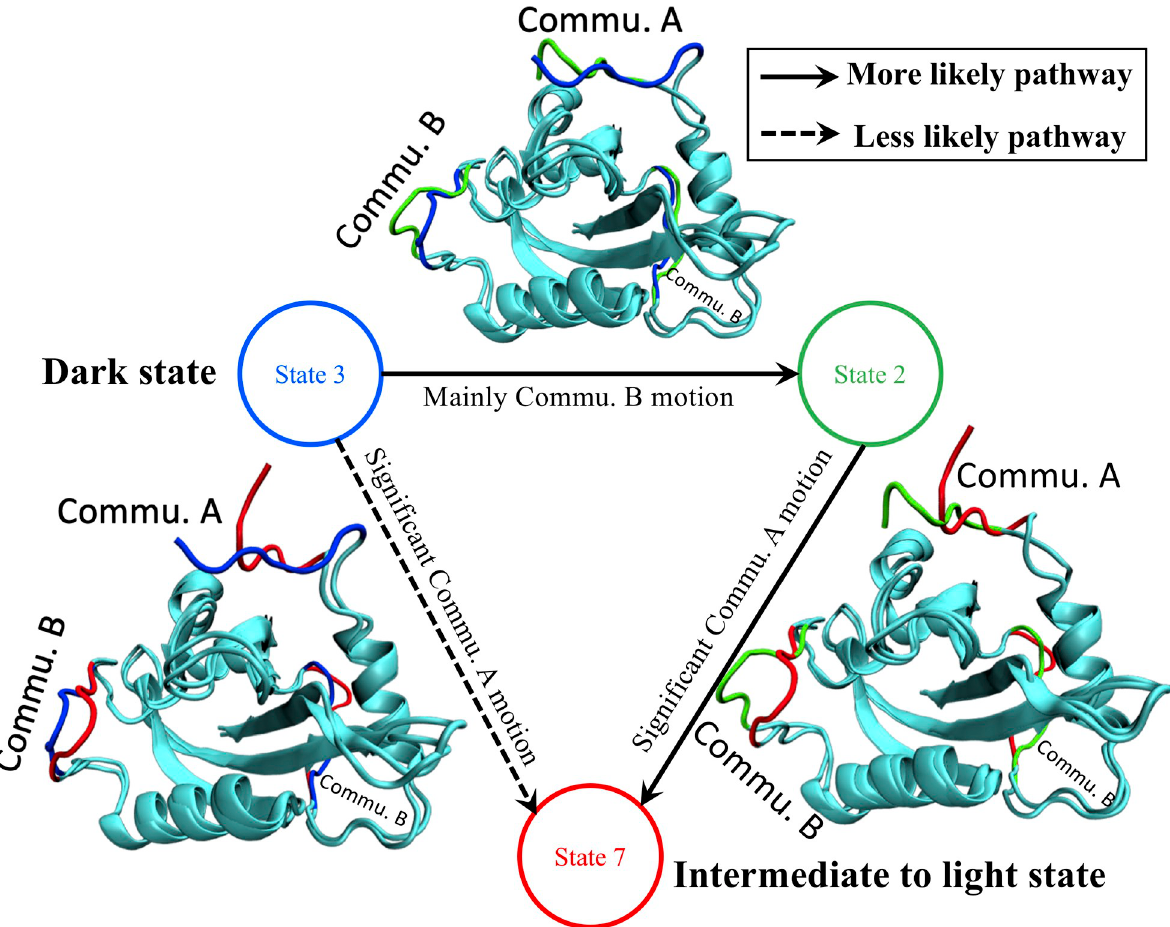
Fig 11. Proposed transition mechanism starting from the dark state of VVD as state 3. Commu. B may function as a switch to be turned on first (State 3 to 2) and lead the conformational change of Commu. A (N-terminus) (State 2 to 7). Commu. A and B are illustrated in blue for State 3, green for State 2, and red for State